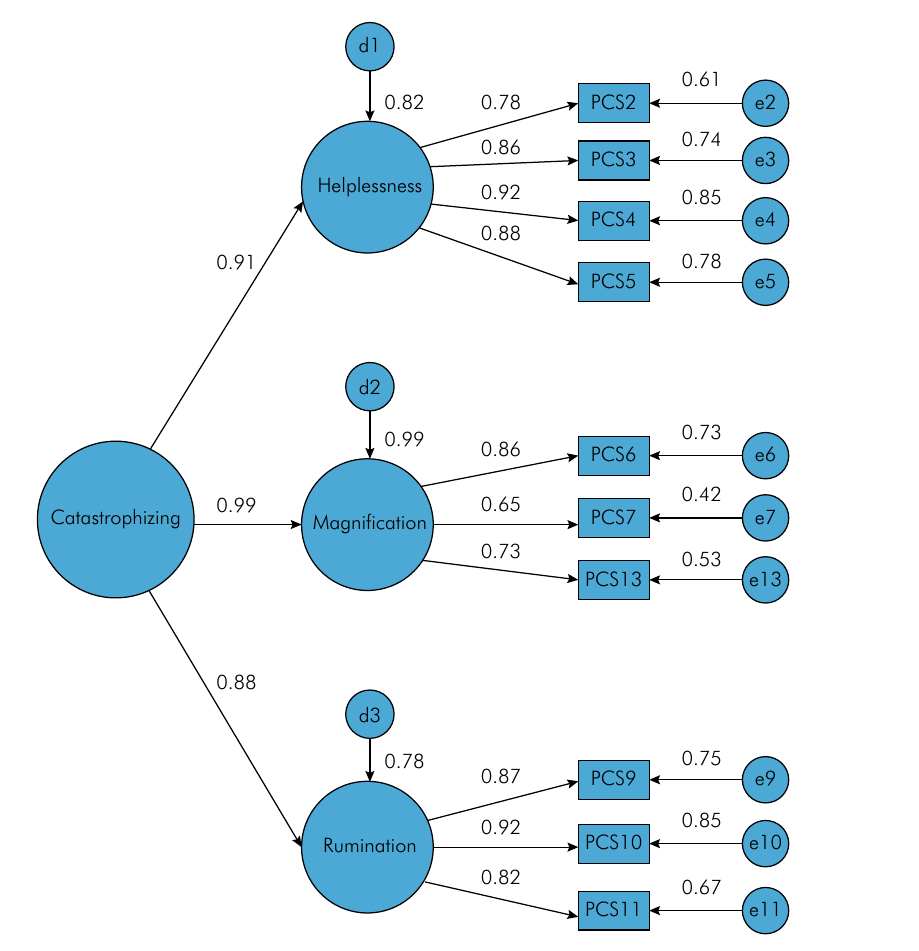
Figure. Second order hierarchical model (HM) of the Pain Catastrophizing Scale applied to the total